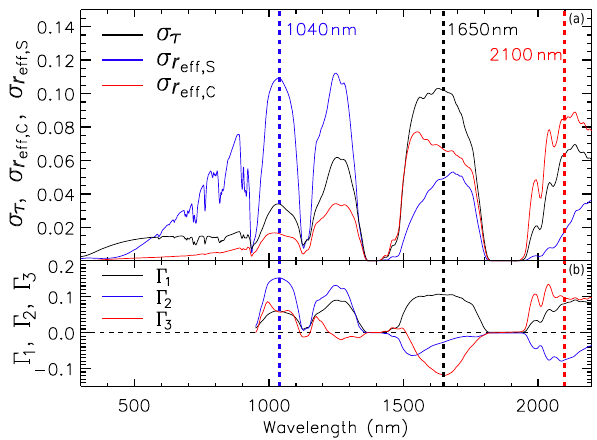
Figure 4. Mean standard deviations of spectral cloud reflectivity σ τ , σ r , and σ r with respect to a single cloud or snow param- eff , C eff , S eter τ , r eff , C , and r eff , S calculated for the sets of radiative transfer simulations (a) . The first three spectral weights (cid:48) 1 , (cid:48) 2 , and (cid:48) 3 of a principle component analysis are given in (b)